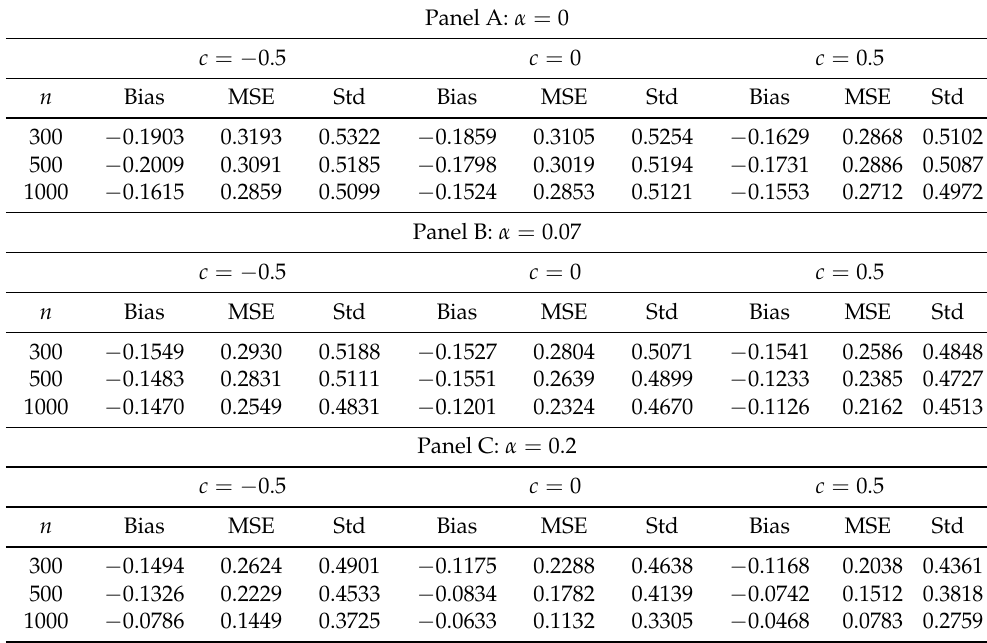
Table 3. Simulation results with ρ =